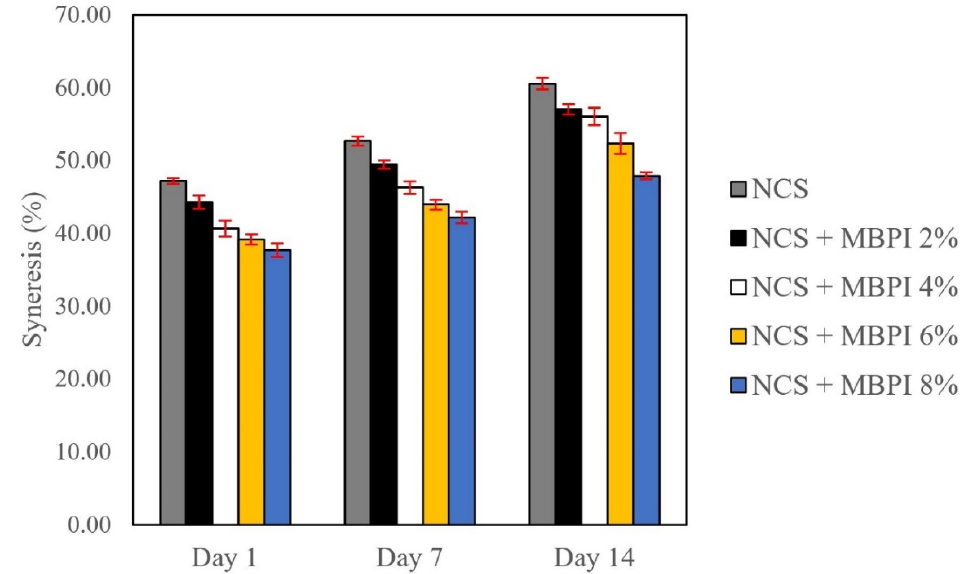
Figure 5. The syneresis of NCS and NCS/MBPI gels during refrigerated storage for 1, 7, and 14 days.